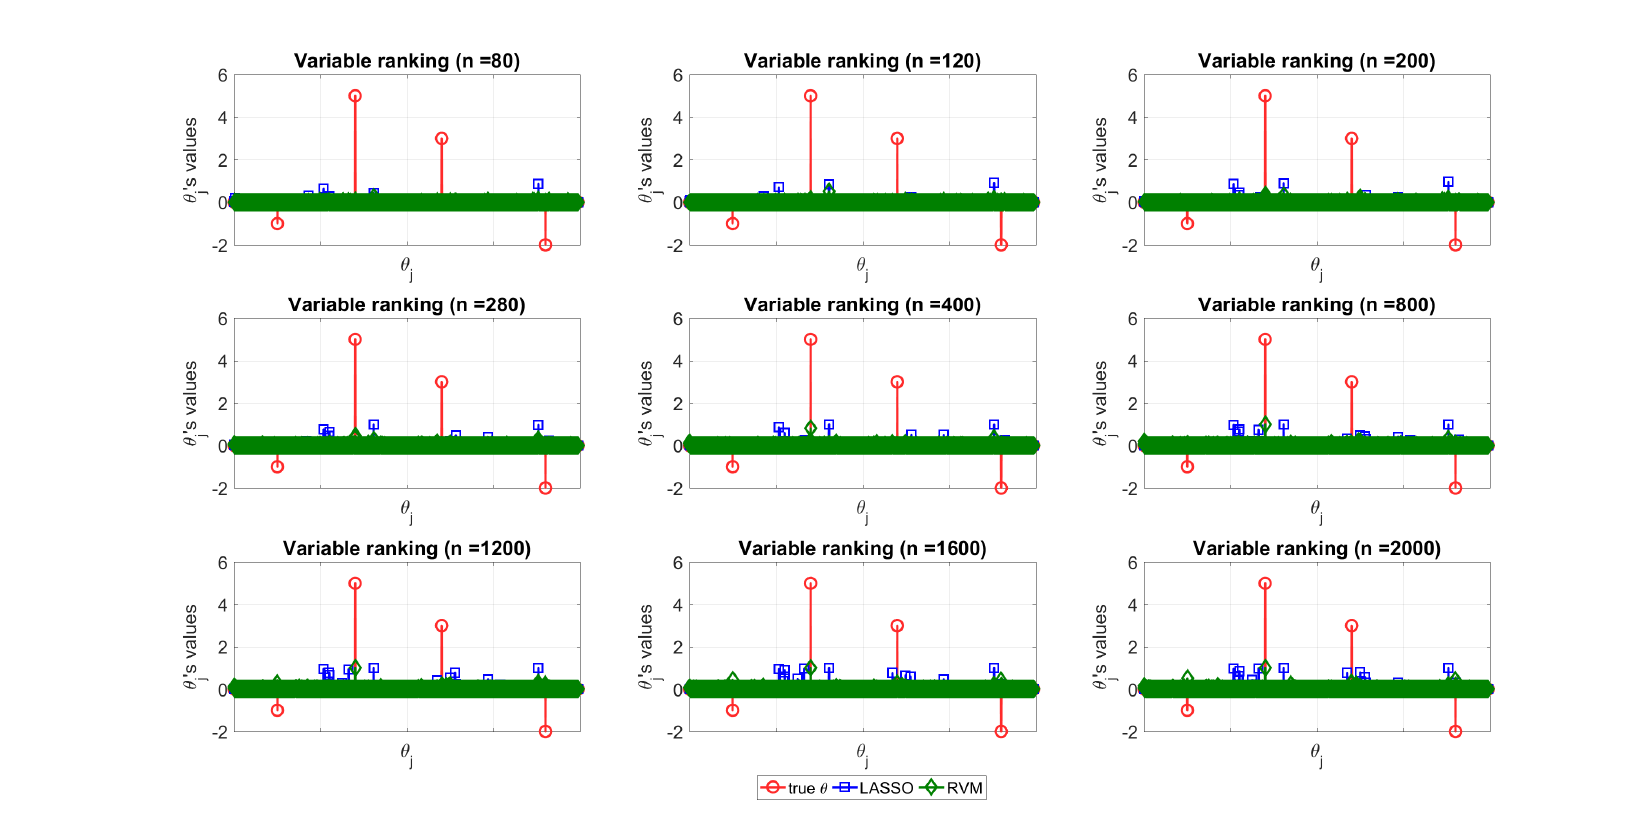
Figure 4. Coefficients estimated with LASSO (blue) and RVM (green) compared with the real ones (red) for dataset